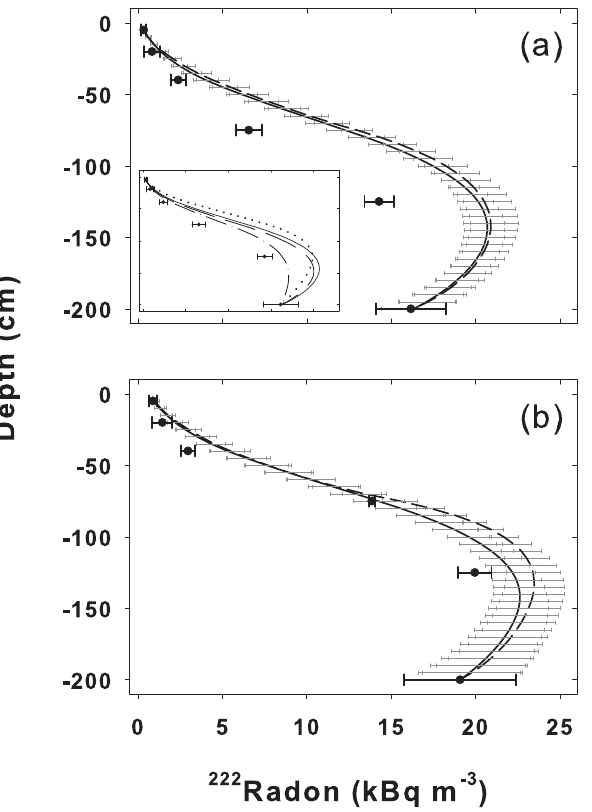
Fig. 1. Mean ( ± SE, n =3) measured Rn concentrations in soil air ( • ) during (a) dry and (b) wet season. The lines show the steady state profiles ( ± SE, n =3) simulated with a Rn mass balance model using the physically modeled diffusion coefficients ( D ; −− ) and the constrained inversely modeled D (—). The inset graph in (a) illustrates the sensitivity of the simulated Rn concentrations: The lines display the steady state modeled concentration profile using the constrained inversely modeled D (—), the response to a 20% increase ( −− ) or decrease ( ··· ) in D , and the response to a 20% reduction in the Rn production rates (– · –).